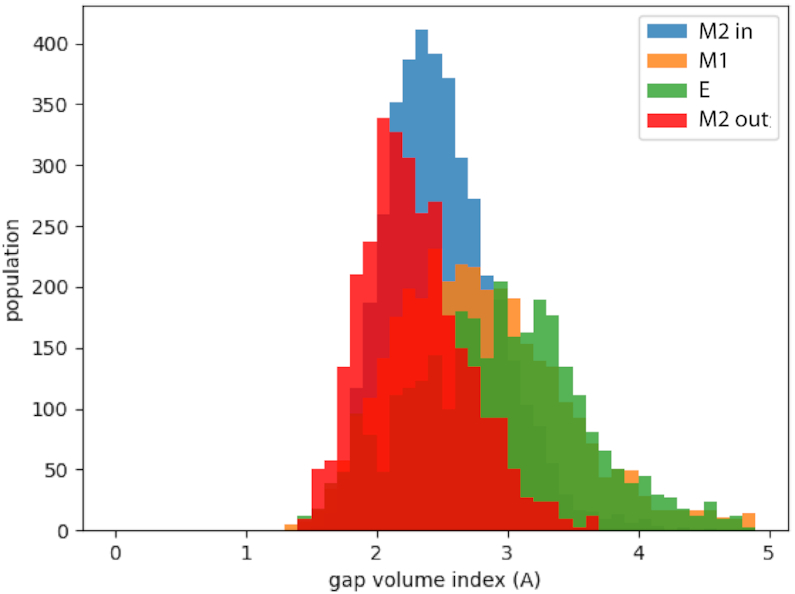
Distributions of the gap index (g) for the four systems. The computed average values are: <gM2out > =2.3 ± 0.4; <gM2in > =2.4 ± 0.4; <gM1 > =2.8 ± 0.7; <gkink> =2.9 ± 0.7.